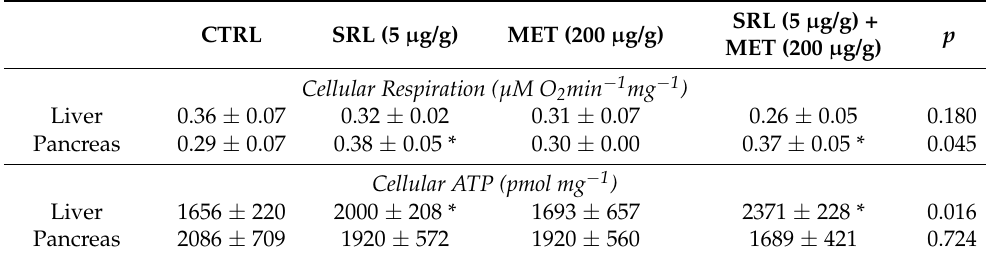
Table 1. Liver and pancreas cellular respiration and ATP content in mice treated with water (CTRL), sirolimus alone (SRL), metformin alone (MET), or a combination of SRL and MET(SRL + MET).